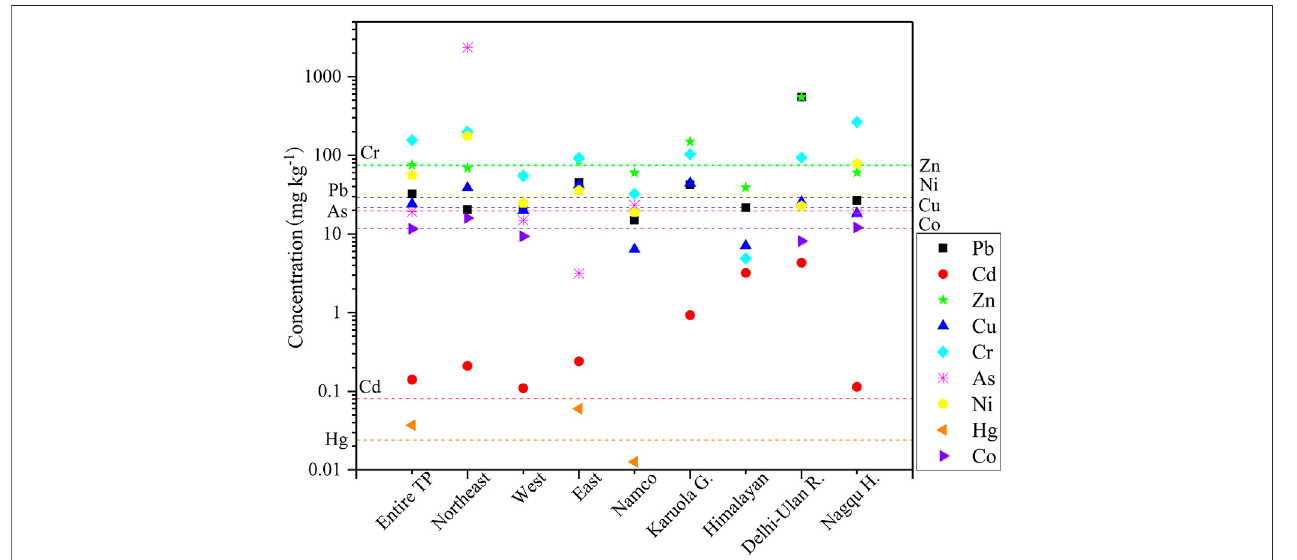
FIGURE 2 | HMs concentrations in the topsoilsamples (0 – 20 cm) over the TP (Li et al., 2009; Wang et al., 2009; Sheng et al., 2012; Zhang et al., 2013b; Xie et al., 2014; Zhang H. et al., 2015; Zhang et al., 2019; Li et al., 2020a; Salim et al., 2020). Notes: The dotted line is HMs background value of soil in Tibet (MEPC, 1990).